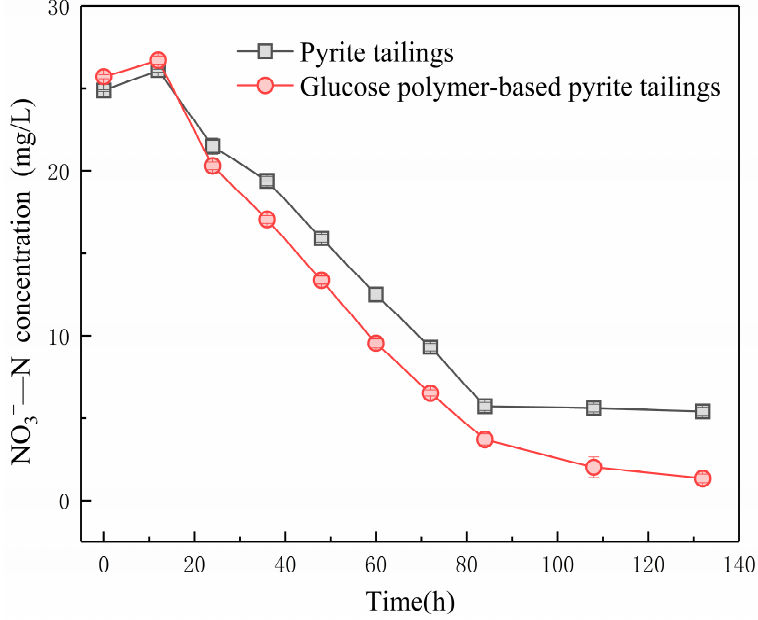
Figure 4. Variation diagram of NO 3 − -N concentration in denitrification system before and after pyrite tailings coating.